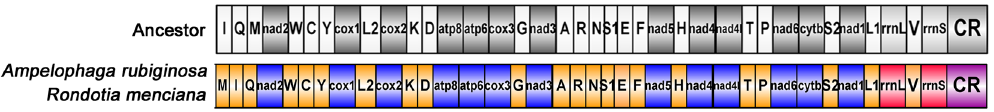
Figure 2. The mitochondrial gene order of ancestral insects and A . rubiginosa and R . menciana .